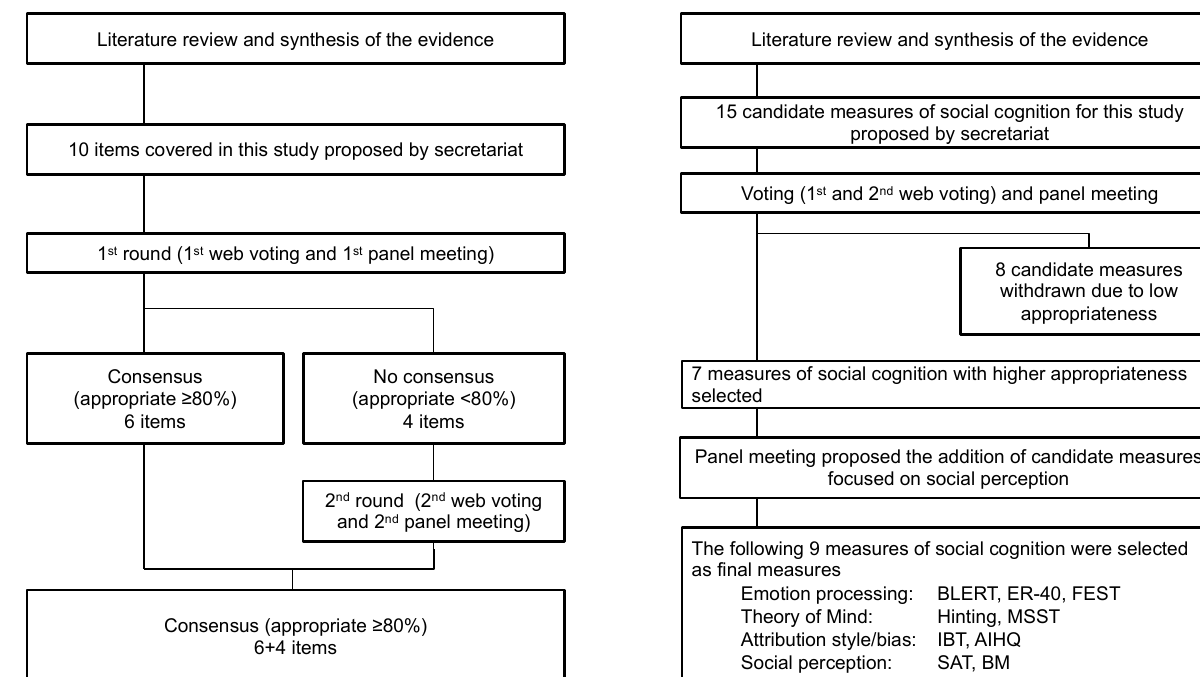
Figure 1. Overview of voting process.